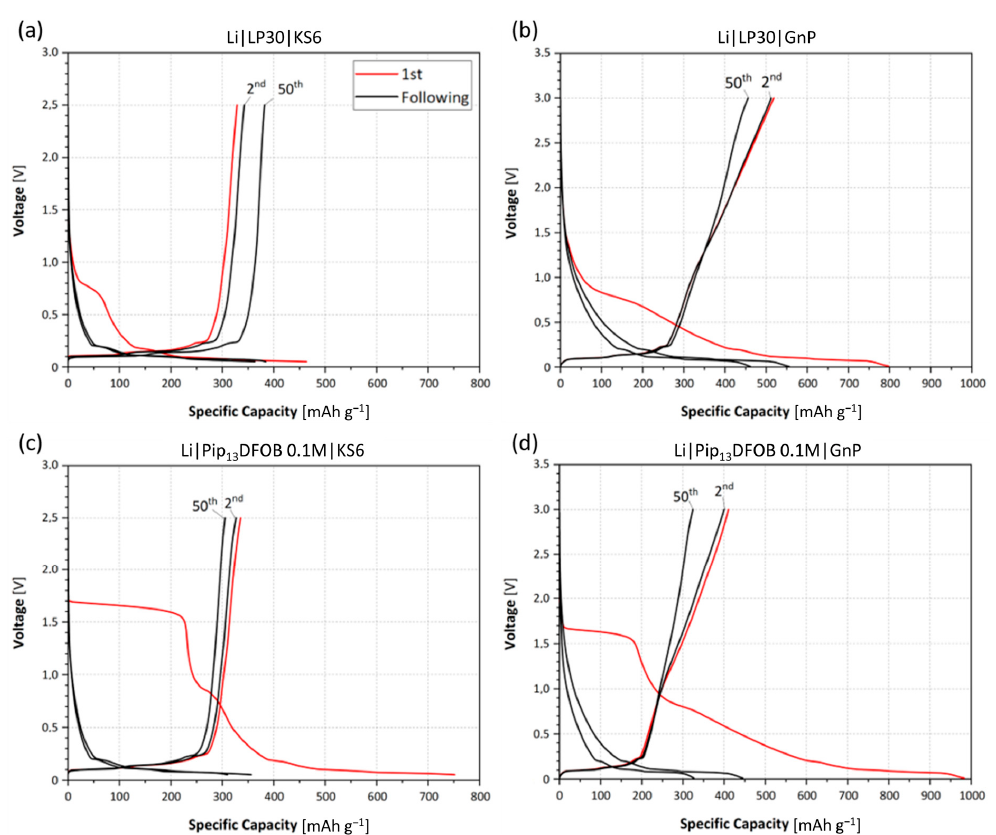
Figure 7. Voltage profiles of the 1st, 2nd, and 50th cycle of Li|KS6 cell without ( a ) and with ( c ) the